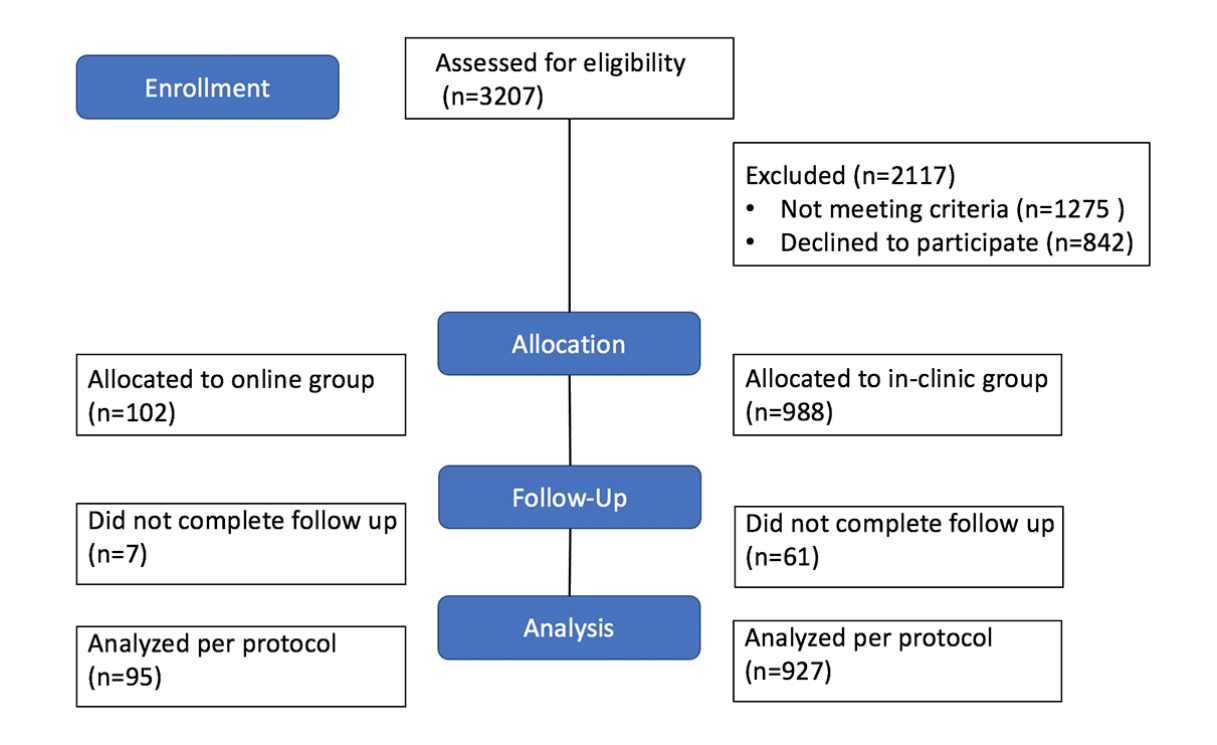
Figure 1. Schematic of participant